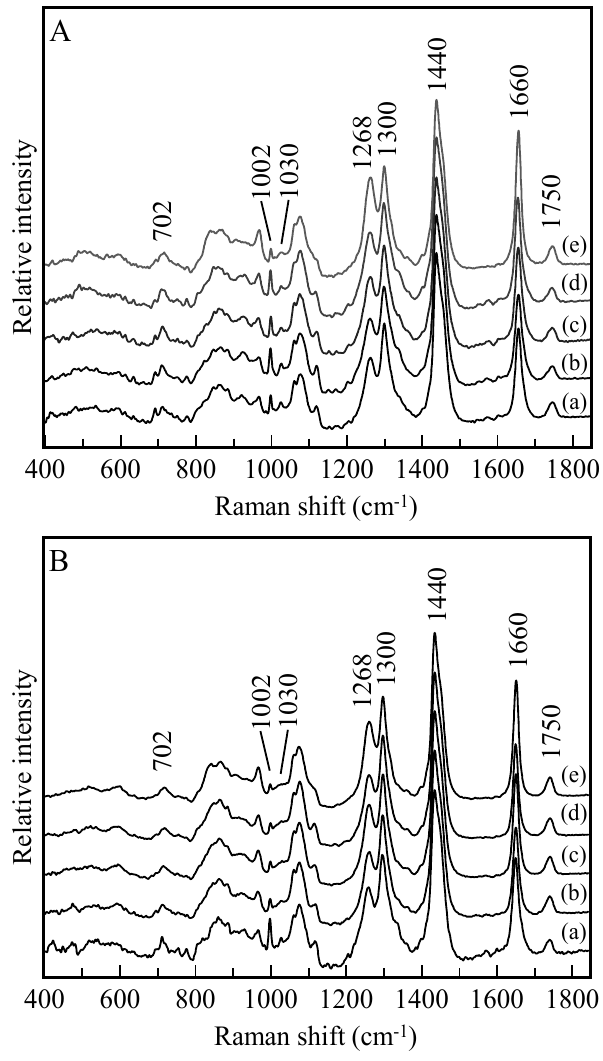
Figure 4. Averaged Raman spectra of lipid droplets measured on days 1 ( A ) and 5 ( B ). The spectra were obtained from the cells cultured without fatty acid ((a); control) and those cultured with palmitic (b), stearic (c), oleic (d), and linoleic (e) acids.